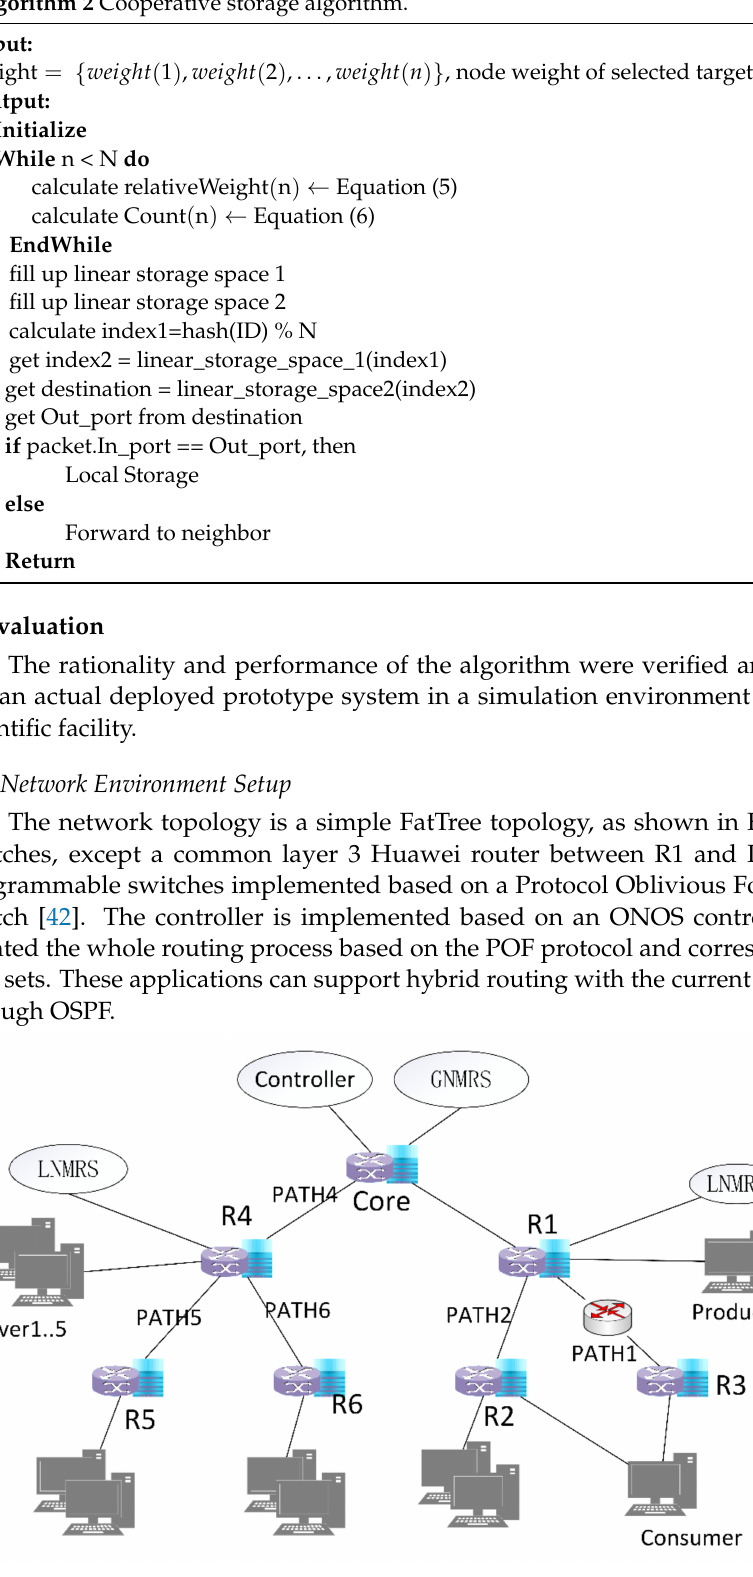
Figure 6. Network topology in the